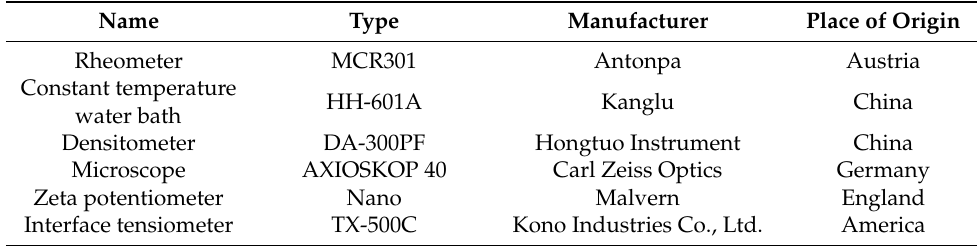
Table 2. Instrument model and country.